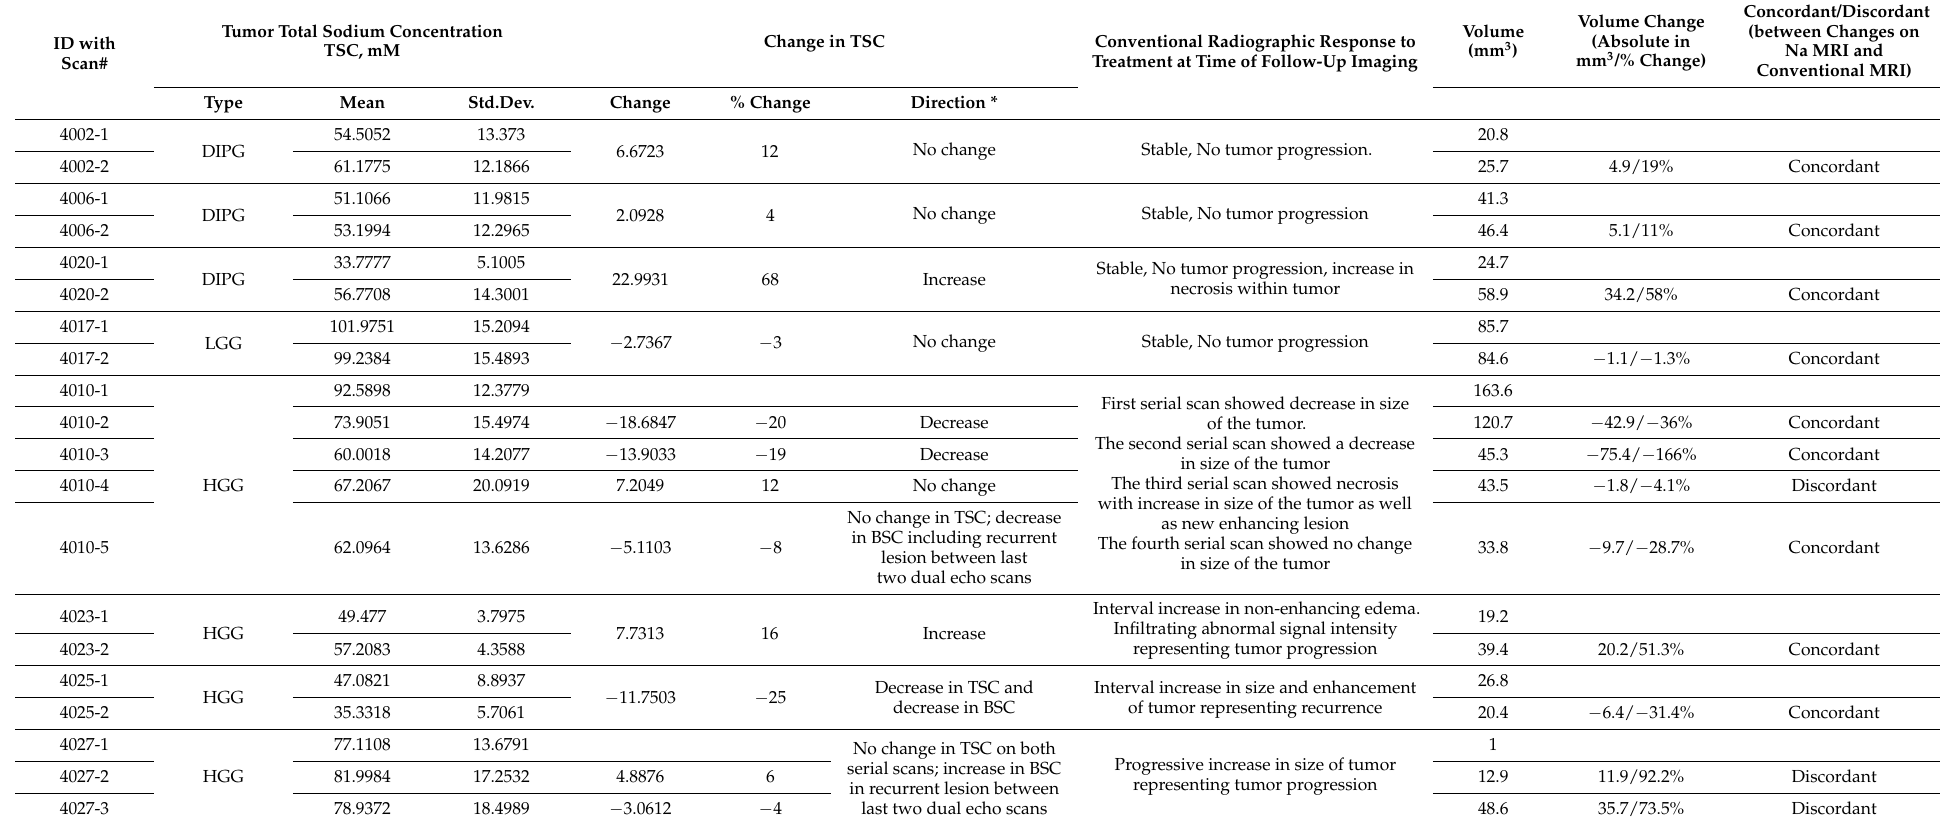
Table 2. Serial follow-up sodium ( 23 Na) MRI Scans in Evaluation of Pediatric Glioma